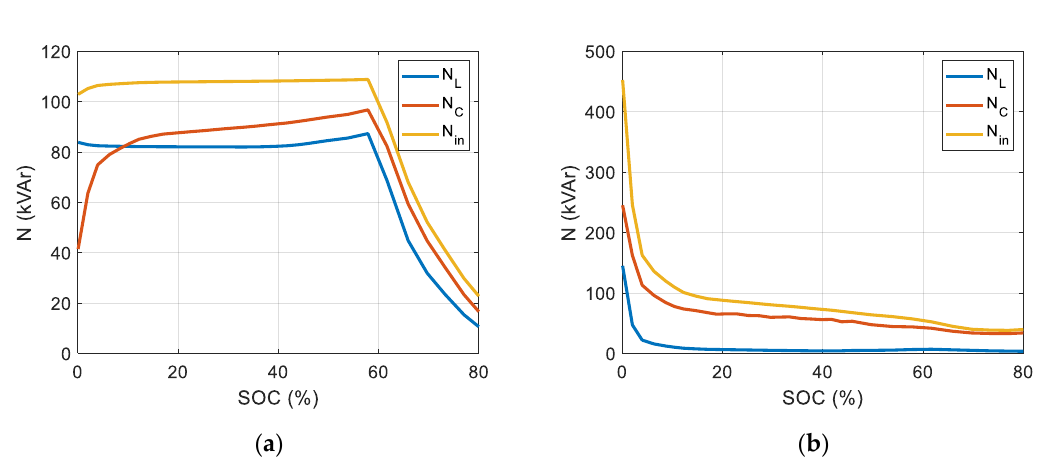
Figure 8. Processed non-active power by the components. ( a ) DAB-FPP; ( b ) DAB-PPP.